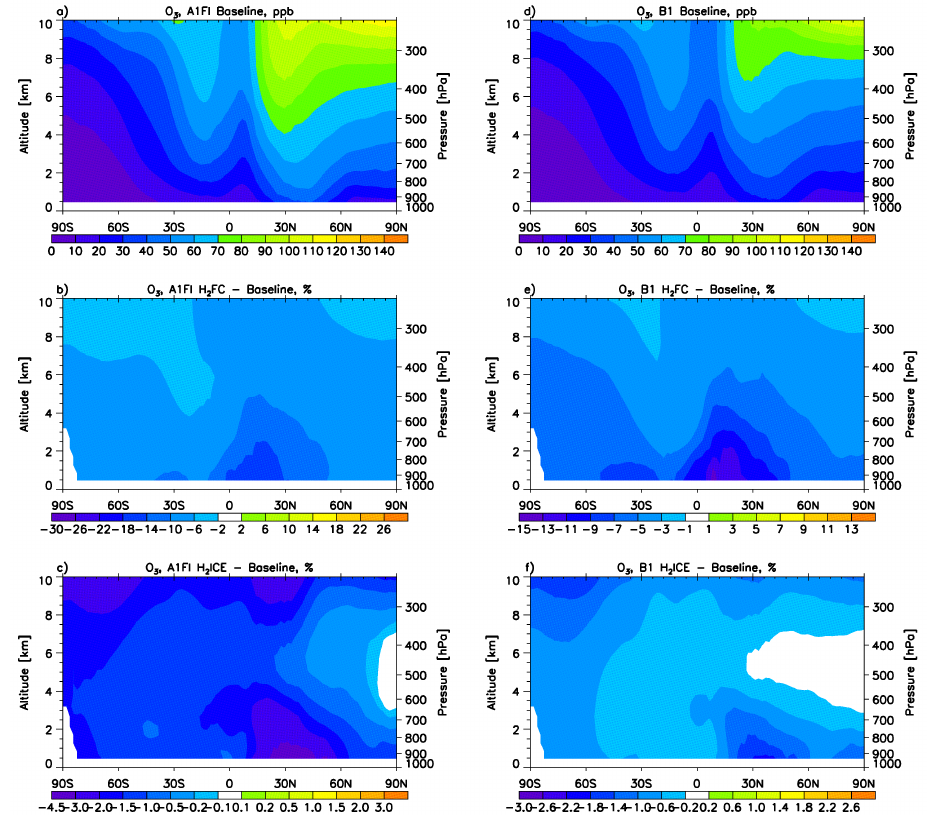
Figure 4. CAM-Chem simulated 2050 NH summer (June, July, and August) average zonal-2 Fig. 4. CAM-Chem simulated 2050 NH summer (June, July, and August) average zonal-mean O 3 mixing ratios in the A1FI (a) and B1 (d) baseline scenarios and percent differences for the H 2 fuel cell (H 2 -FC) and H 2 internal combustion engine (H 2 -ICE) scenarios (b, c, e, f) . mean O mixing ratios in the A1FI (a) and B1 (d) Baseline scenarios and percent differences 3 3 Note the different scales. for the H Fuel Cell (H -FC) and H Internal Combustion Engine (H 2 2 2 and f). Note the different scales. 5